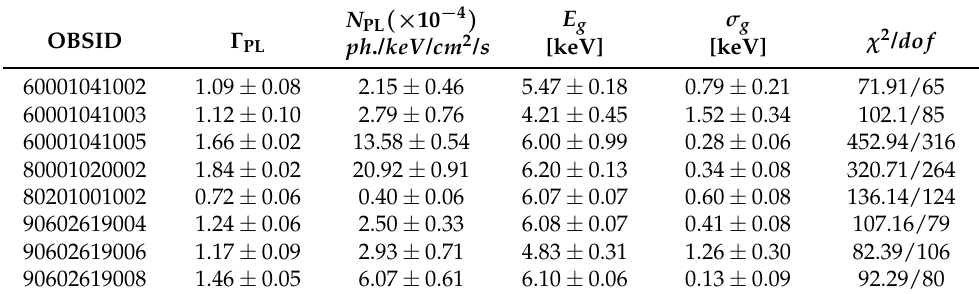
Figure 1. Spectra of all eight observations in the 3–30 keV energy range. Variability of the source is evident. Table 2. Best-fitting parameters with the TBABS ( GAUSS + PL )